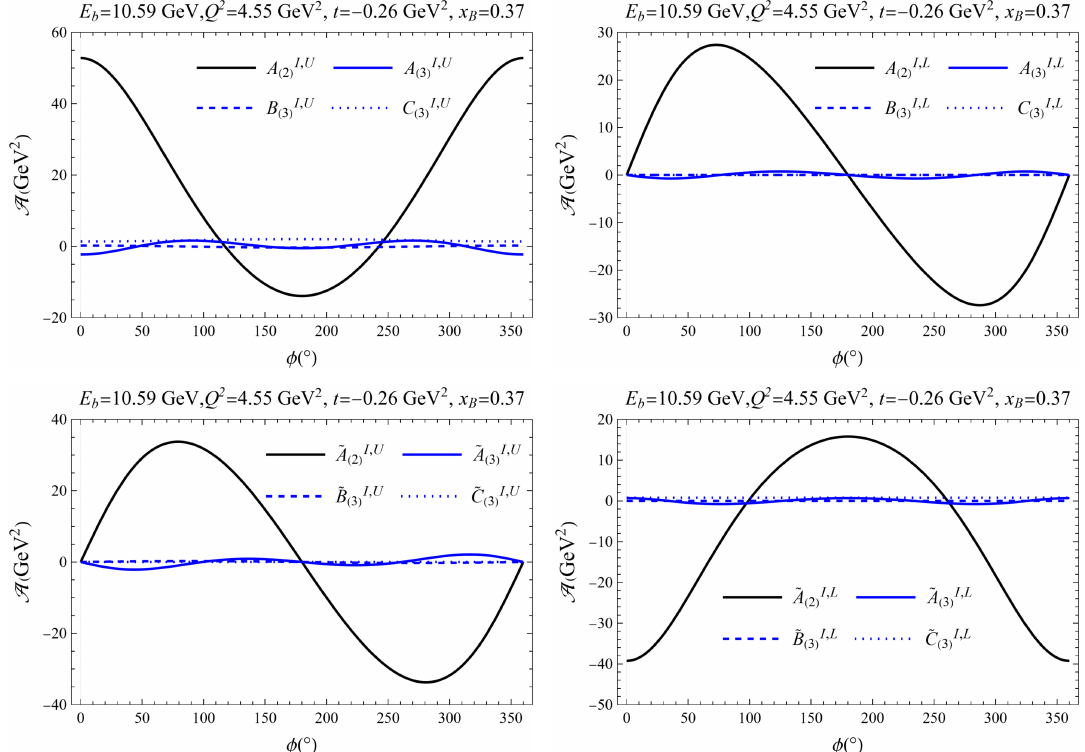
with A = { A, B, C, e A, e B, e C } (3) and e A I , U / L as the (2) (2)